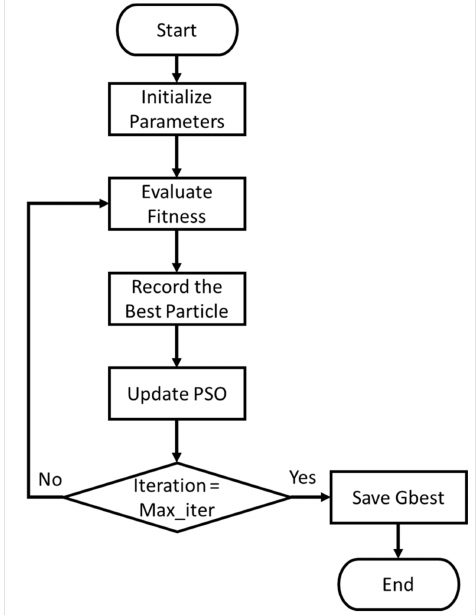
Figure 7. Flow of fuzzy